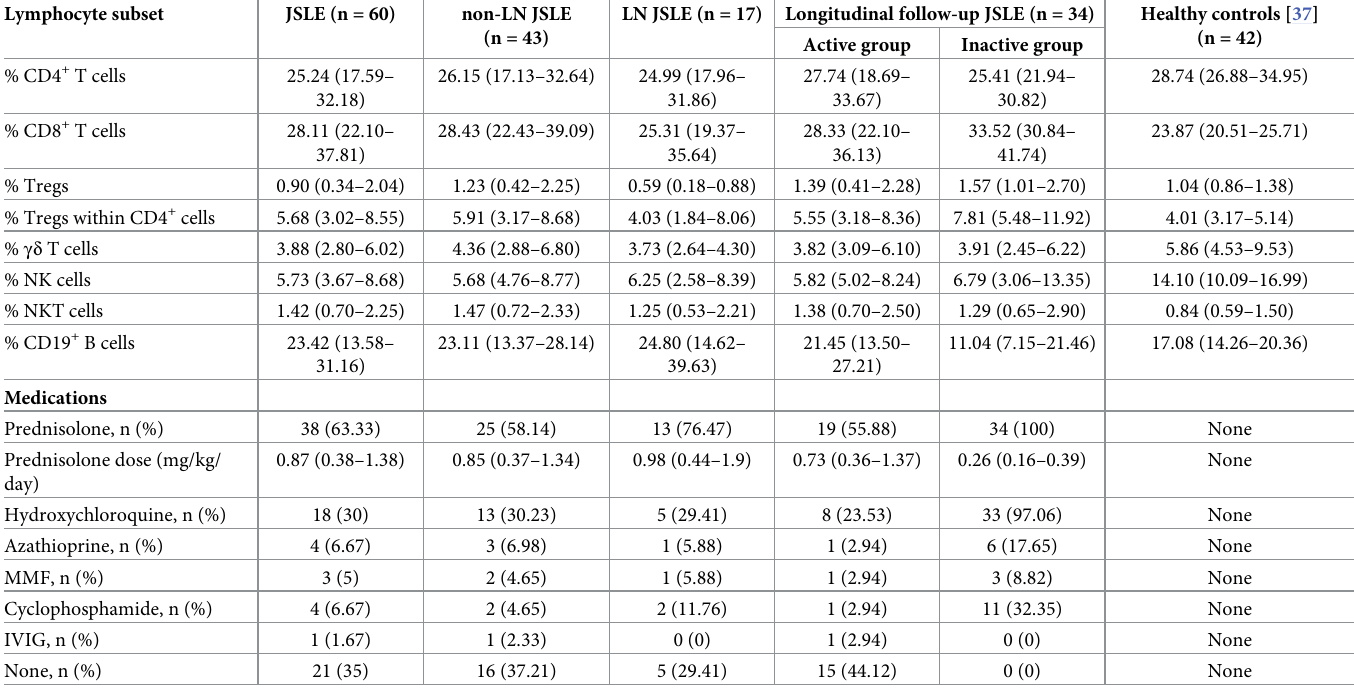
Table 2. Percentages of lymphocyte subsets in the juvenile-onset systemic lupus erythematosus patients. Lymphocyte subset